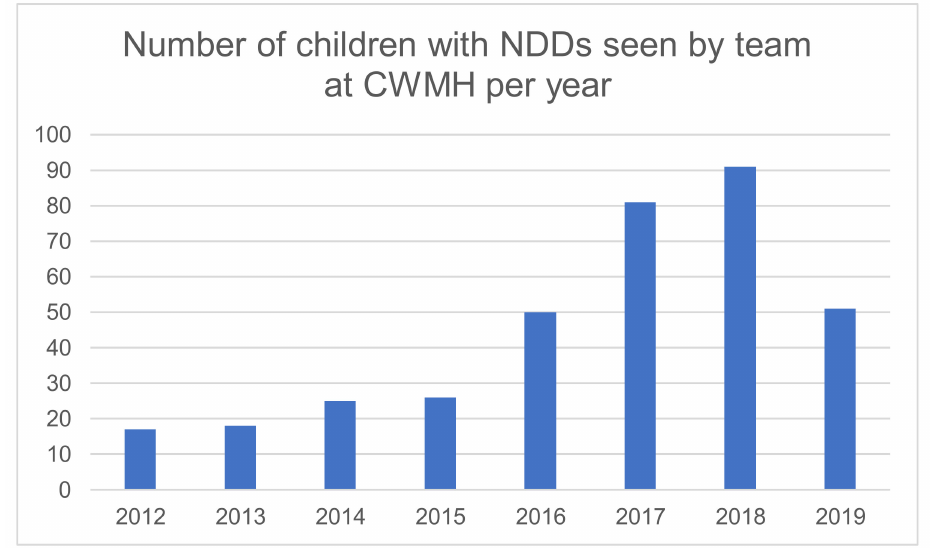
Figure 4. Total number of children with Neurodevelopmental Disabilities (NDDs) seen by the